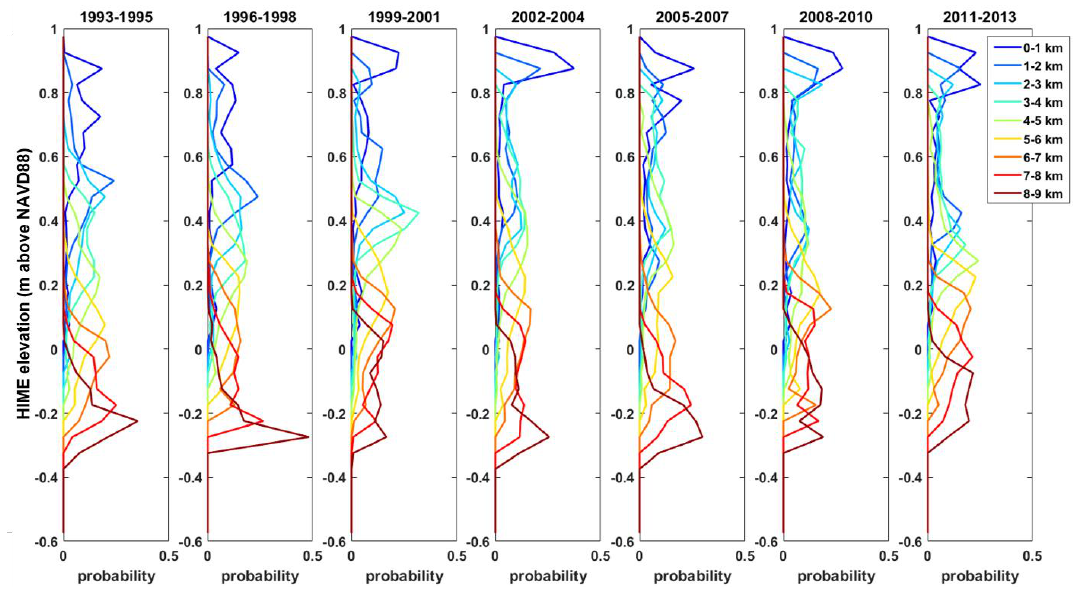
Figure 8. Probability distributions of WLD elevations (m, in 0.05 m bins) in each 1 km-band of distance from the delta apex (color-coded), and change within each band over time (panels, left to right).